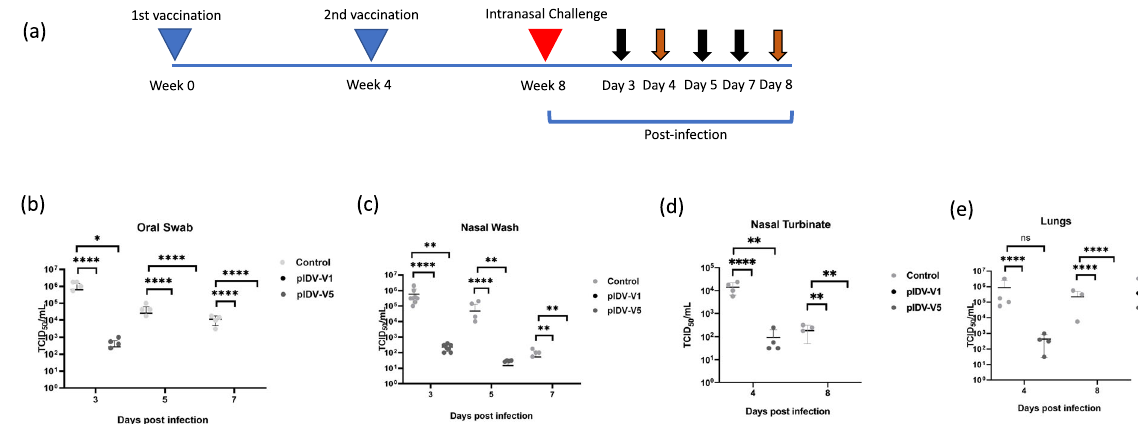
Fig. 4 Vaccination reduces viral shedding and viral RNA load in SARS-Cov2 challenged hamsters. a Vaccination and challenge schedule. Sampling timepoints are shown by black arrows. Groups of animals ( n = 4) were euthanized at 4 and 8 dpi as shown by the orange arrows. Sampling timepoints are shown by black arrows. Titers of infectious virus from various timepoints were collected and determined by TCID50 from b oral swabs, c nasal washes, d nasal turbinates, and e lungs. Error bars represent standard deviation. P value = 0.0001 (****) and 0.0003